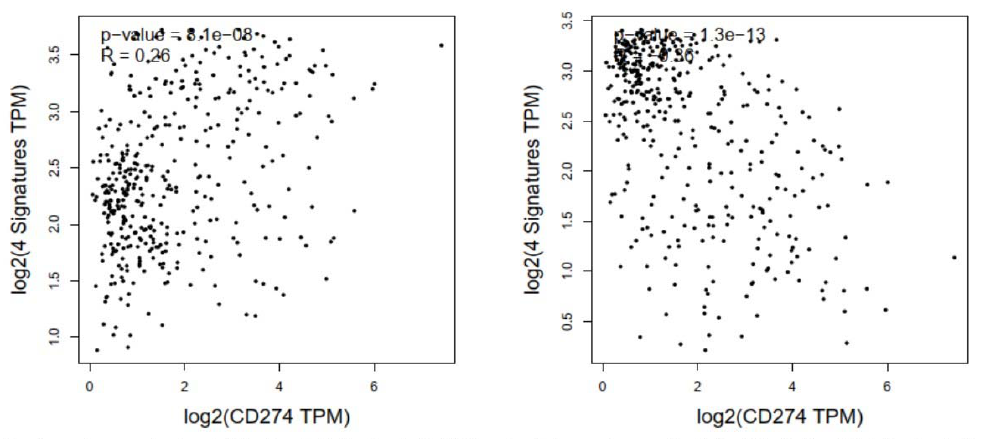
Figure 11. In the bladder carcinomas cohort of TCGA, PD-L1 (CD274) gene expression levels were positively correlated with markers of basal tumors (R = 0.26, p -value < 0.01) and inversely correlated with the luminal genes signature (R = − 0.36, p -value < 0.01).